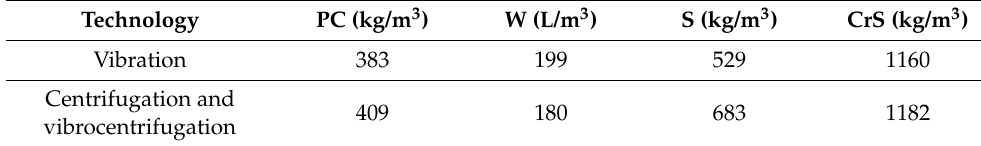
Table 4. Concrete mixing ratios in 1 m 3